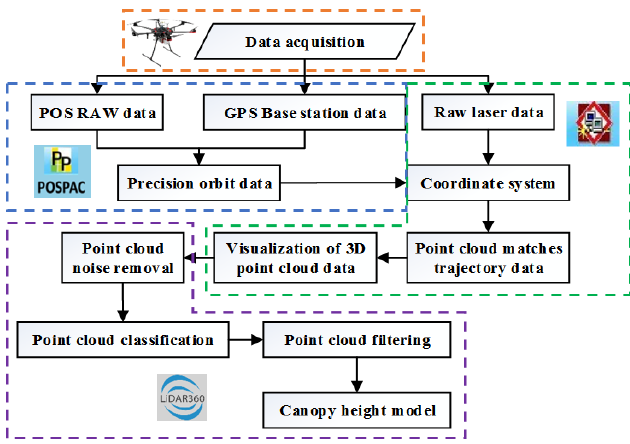
Figure 5. Point cloud data processing process.